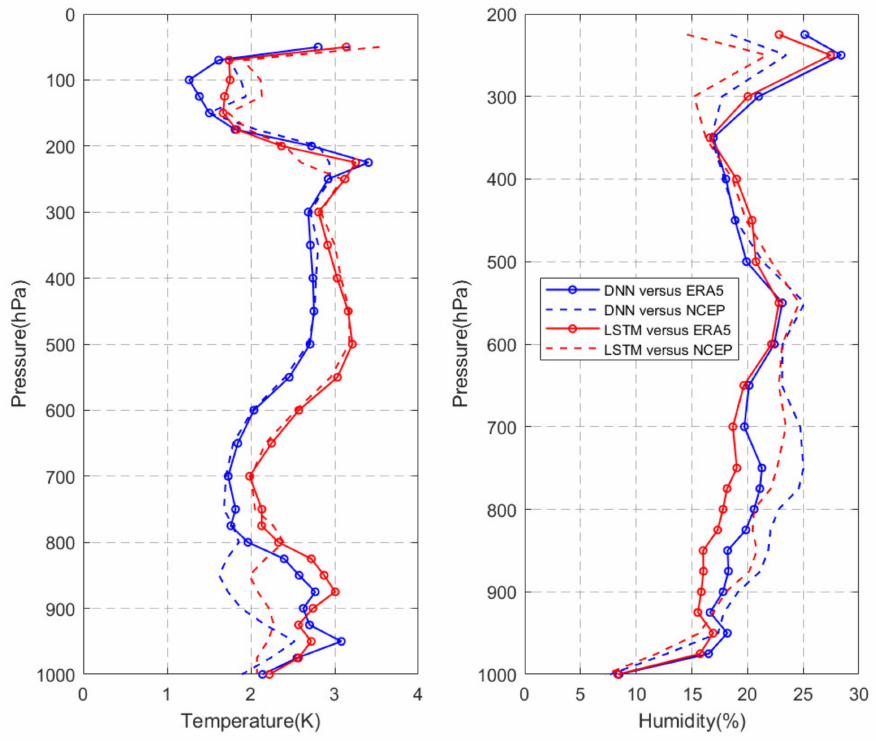
Figure A2. The retrieval RMSEs of the DNN-based model and LSTM-based model with respect to ERA5 and NCEP reanalysis data over sea ice in September